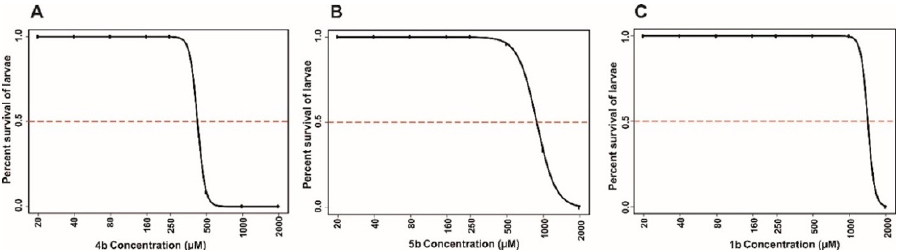
5 of 14 Abbreviations: IC 50 : Concentration of an inhibitor where the response is reduced by half; Normoxia (N); Anoxia (A); Hypoxia selectivity cytotoxicity ratio (HCR). Based on its selective cytotoxicity under anoxia in both cell lines, compound 1b was selected for further studies, investigating its effects on cell survival. Compound 1b did not reduce clonogenic cell survival under normoxia or anoxia at the tested concentrations (Figure 2). TH-302, a 2-nitroimidazole based hypoxia-activated prodrug-alkylating agent was used as positive control (data not shown) [34]. Figure 2. Clonogenic cell survival of ( A ) HT29 and ( B ) HCT116 cells during normoxia (white bars) and anoxia (black bars) when exposed to compound 1b. The data represent the average ± SEM of three independent biological repeats. 2.4.2. Toxicity Evaluation on Zebrafish During development, zebrafish embryos are easily affected by chemical compounds compared to adult zebrafish or other animal models or cell models and are therefore suitable for assessing the subtle toxic effects of chemicals [28,30]. The toxicity of compound 1b , 4b and 5b was determined by using 24-h post-fertilization zebrafish embryos [35]. In these tests, the LC 50 , zebrafish phenotypic parameters and the swim pattern were analyzed for each compound. Determination of Half Maximal Lethal Concentration 50 (LC 50 ) The lethality of 1b , 4b and 5b on the developing zebrafish embryos was concentration dependent (Figure 3). Among the three compounds tested for the toxicity, 1b was the less toxic and did not cause any mortality of the larvae, even at a 1 mM concentration at the end of 5 day of exposure to the compound. Compound 4b was more toxic compared to the other two compounds and caused